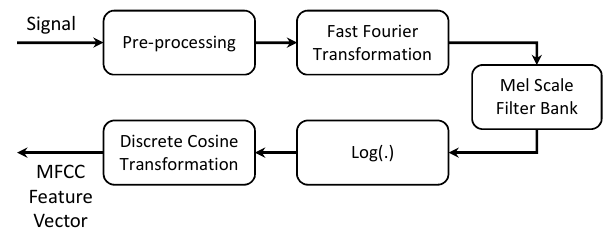
Figure 2. Block diagram of MFCC feature vector calculation.